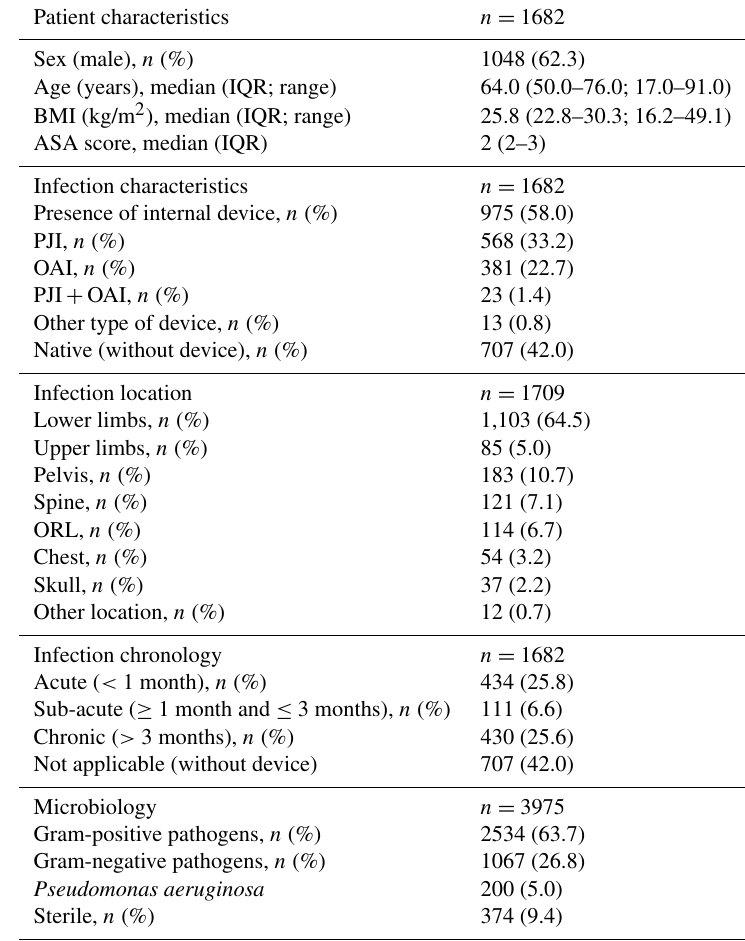
Table 1. Patient and infection characteristics. IQR – interquartile range; BMI – body mass index; ASA – American Society of Anesthesiol- ogists; PJI – peri-prosthetic joint infection; OAI – osteosynthesis-associated infection; ORL – otorhinolaryngology.